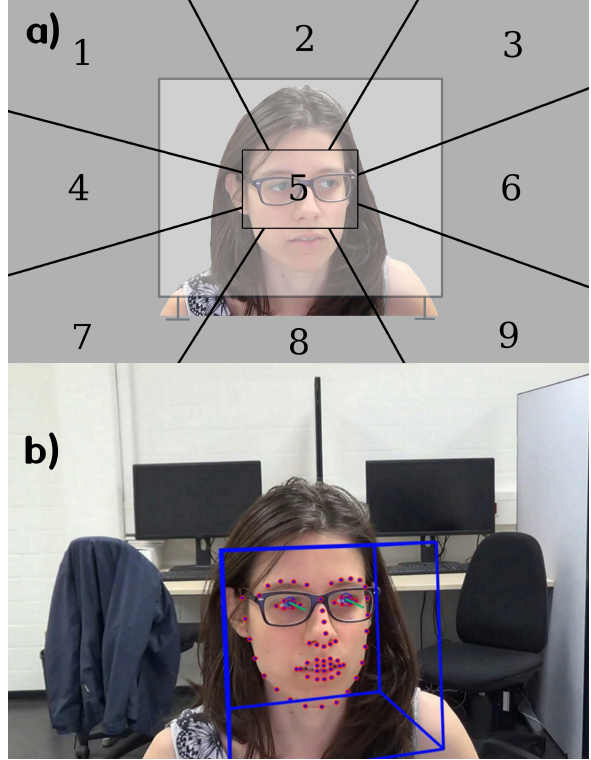
Figure 1. a) Coding grid used for the manual annotation. The inclusion of the translucent screen in the image depicts the non- bounded spatial extension of the radial grid sections. During annotation, the grid was mentally super-imposed upon the video footage. This grid was super-imposed upon the screen during annotation. Since the participants were facing the camera during the recording process, their gazes appeared mirrored. In other words, a leftwards gaze from the viewpoint of the participant was annotated as ‘6’, which is found on the right-hand side of the coding grid. Similarly, a participant gazing towards the lower right side was annotated as ‘7’. Note that there was a tenth gaze direction ‘0’ which was used whenever participants looked into the camera or closed their eyes for a longer period. b) Visual output of OpenFace. The blue box represents the head pose position. The dots represent the landmarks, and the green lines represent the eye-gaze vectors which were used in our